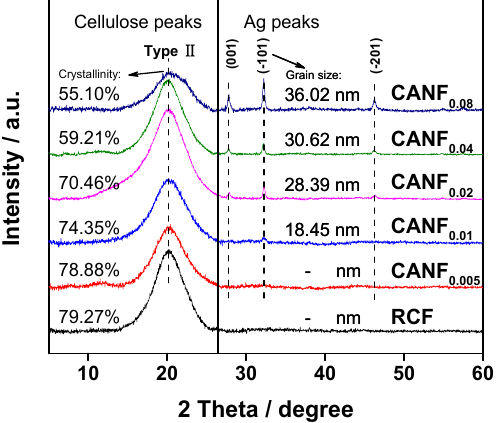
Figure 5. XRD patterns of composite films.